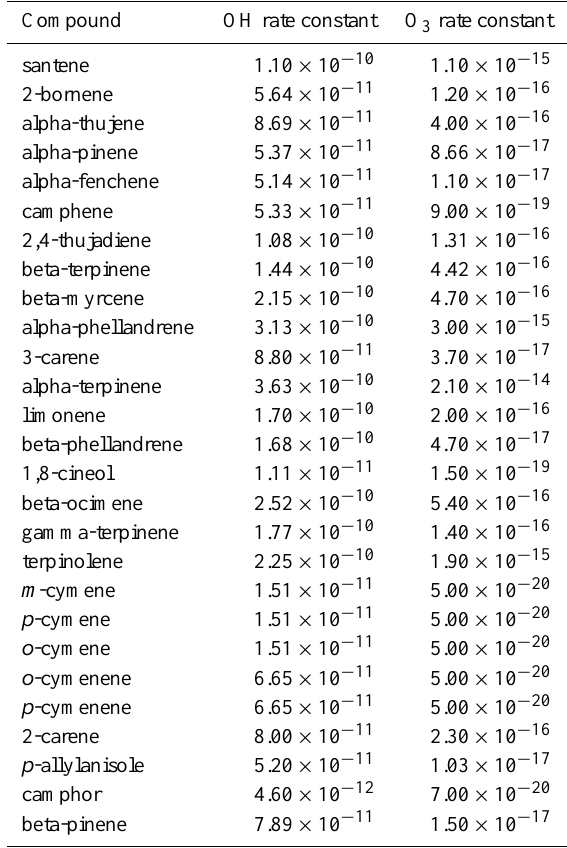
Table 3. Reaction rate constants for monoterpenoids at 298 ±